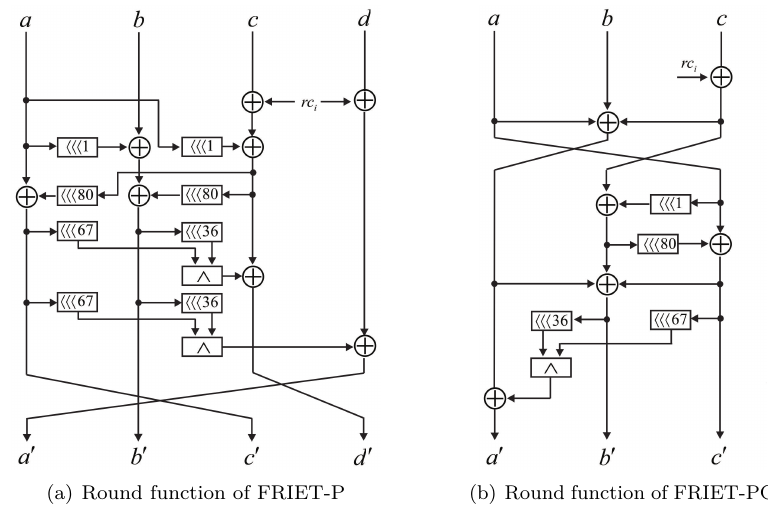
Figure 1: The round function of FRIET [SBD +